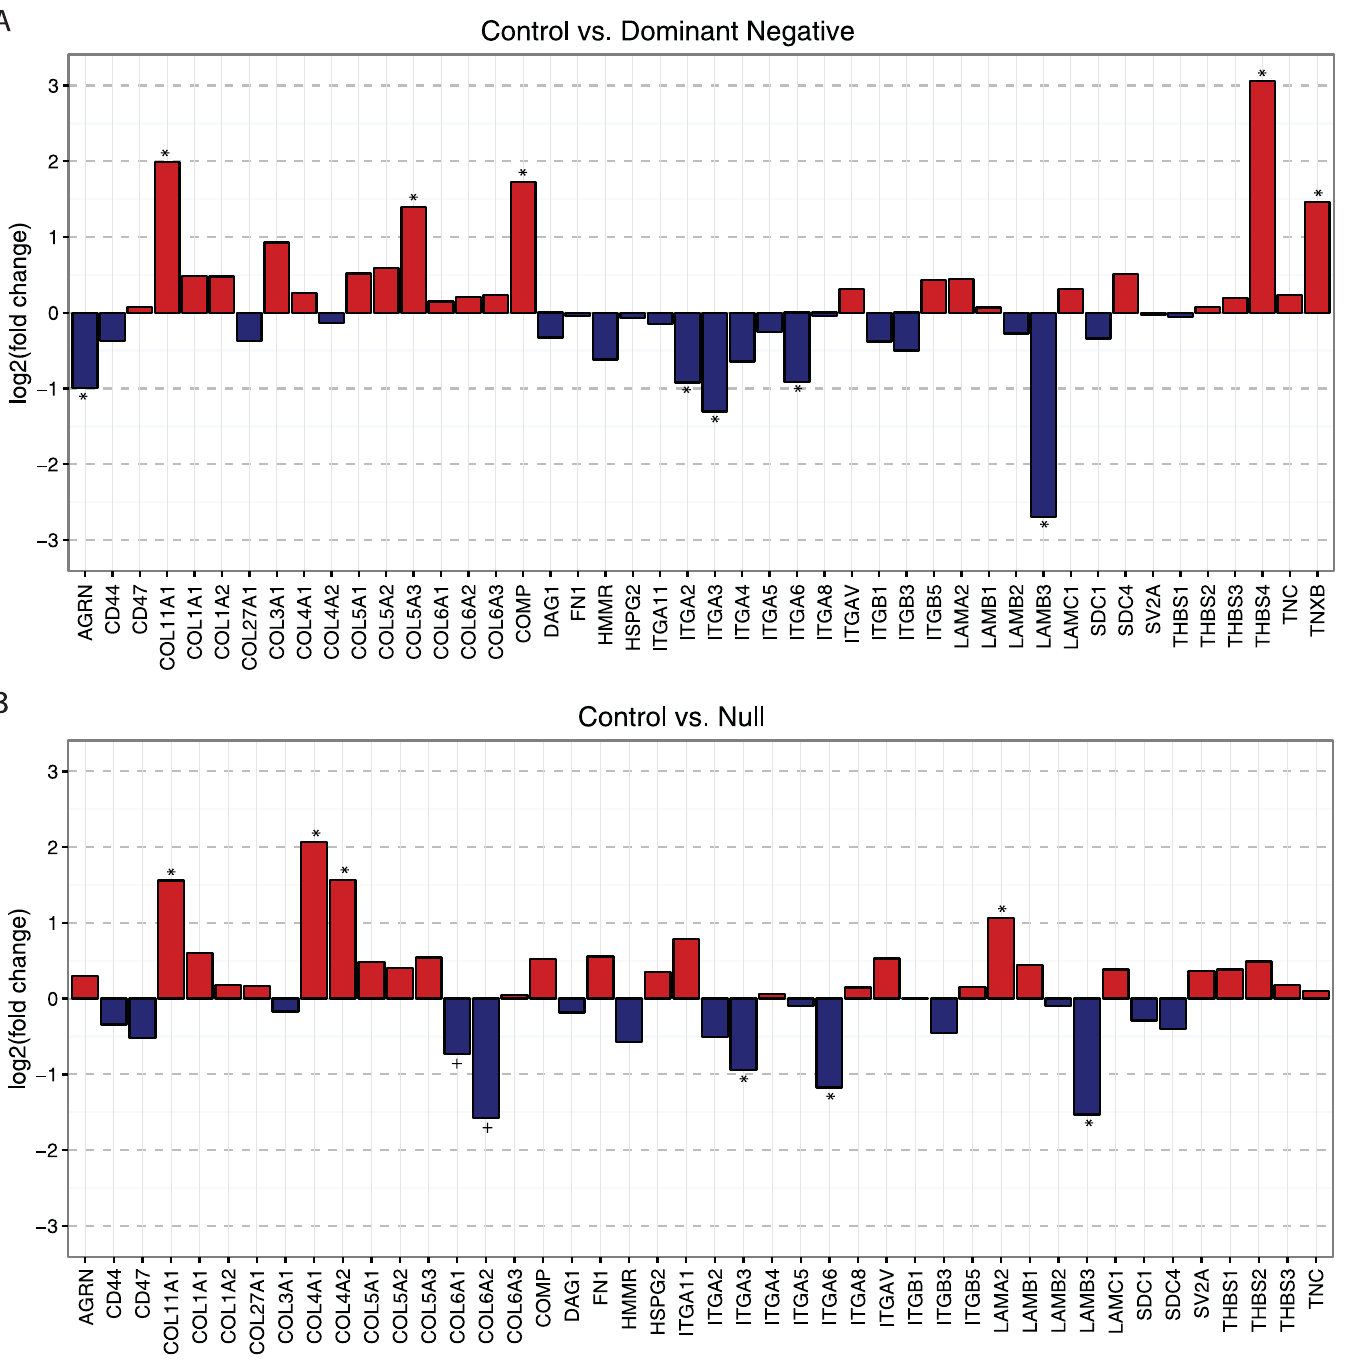
Fig 2. Differential expression of genes in the ECM-receptor interaction pathway. Differential expressionof genes in the ECM-receptor interaction pathway (hsa04512) for control vs. dominant negativemutation (upper panel)and control vs null mutation (lower panel). Log 2 fold changeis plotted for each gene in the pathway. Genes with significantdifferentialexpression(FDR-adjusted p-value was < 0.05) are marked with an * . COL6A1 and COL6A2 (marked with + in the lower panels) are decreased in null samples as expecteddue to their null allele.